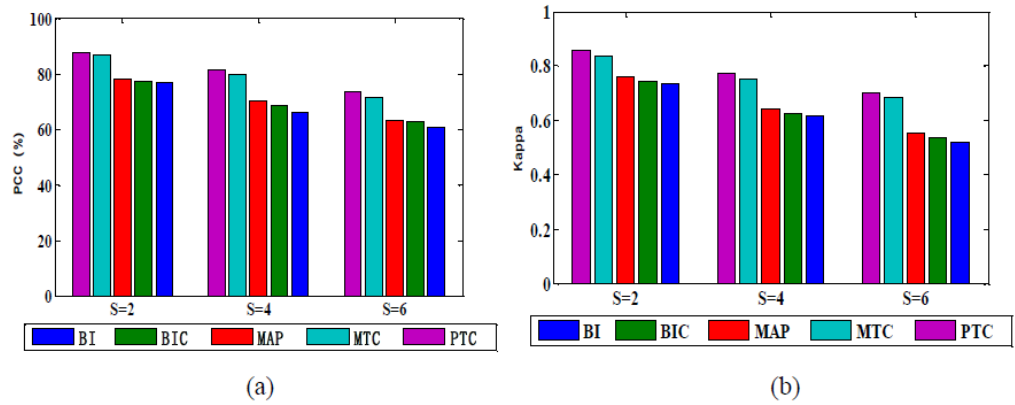
Figure 10. ( a ) PCC (%) of the five methods in relation to scale factor S ; ( b ) Kappa of the five methods in relation to scale factor S .